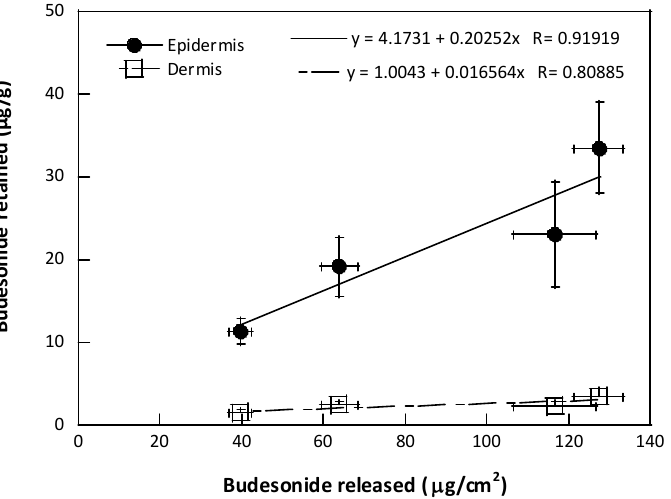
Figure 4. Correlation between the amount of BUD retained in the skin layers and the amount released after 6 h (mean value ± sem).